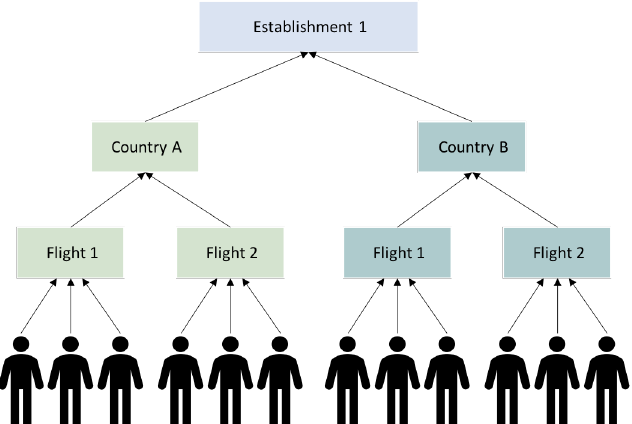
Figure 8. Hierarchy of agents representing international pilgrims. The top-level aggregate represents one of the six establishments where international pilgrims are grouped based on country of origin. The next level consists in country aggregates. Agents on the lowest level are aggregated based on arriving in the same